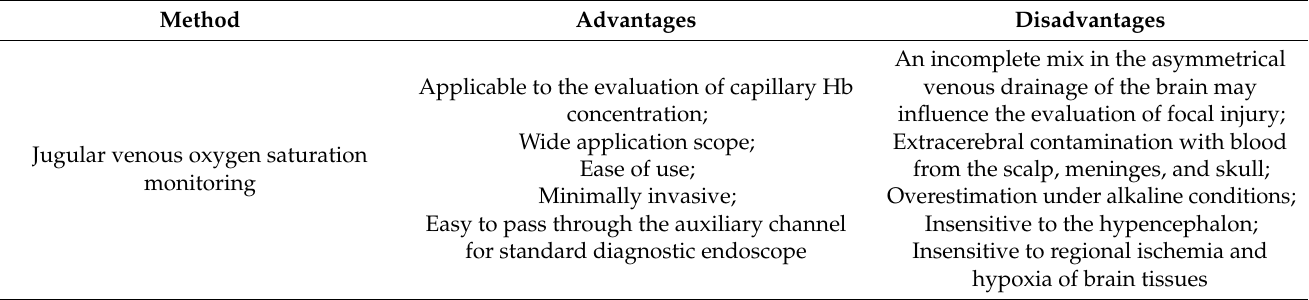
Table 3. Summary of the Advantages and Disadvantages of different